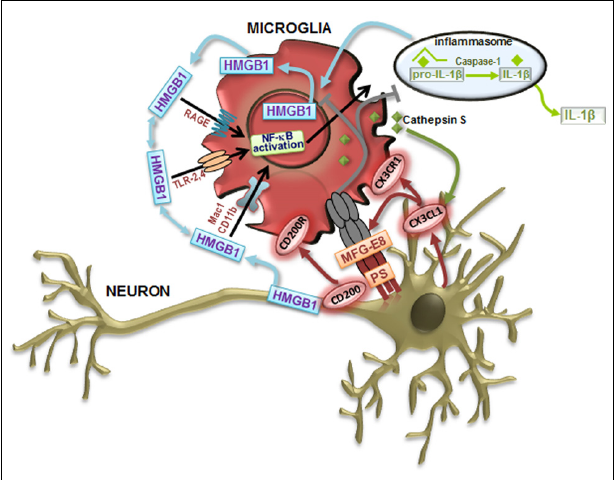
FIGURE 1 | Neuron–microglia communication signaling pathways that modulate microglia cell phenotypes. Toll-like receptor (TLR) signaling contributes to classically activated microglia (M1) in response to damage-associated molecular patterns (DAMPs). Following recognition of DAMPs,TLRs activate downstream signaling cascades, activate nuclear factor- κ B (NF- κ B) inducing the transcription of inflammatory mediators associated with the M1-like microglial cell phenotype, such as the proinflammatory cytokines interleukin (IL)-1 β and tumor necrosis factor (TNF)- α .The production of IL-1 β can be achieved by the inflammasome activation by DAMPs, leading to caspase-1 activation that orchestrates the cleavage of pro-IL-1 β to form active IL-1 β , which leaves and binds to the IL-1 receptor, resulting in inflammation. Following activation, microglial cells augment the immune response by releasing metalloproteinases (MMPs) and increasing proinflammatory cytokines. High-mobility group box 1 (HMGB1) is an alarmin that signals cell damage in response to injury and are associated to all the described signaling events. HMGB1 released by activated microglia and damaged neurons concur for a vicious cycle mediating chronic, progressive neurodegeneration associated with neuroinflammation. HMGB1 can interact with receptors that include RAGE (receptor for advanced glycation end products),TLR-2,TLR-4, Mac-1 also known as CD11b, and possibly others. Alternatively activated microglia (M2) functions include phagocytosis. Milk fat globule factor-E8 (MFG-E8) produced by microglia recognizes phosphatidylserine (PS) as “eat me” signals expressed on the surface of apoptotic neurons, triggering a signaling cascade that stimulates phagocytosis to engulf the dying cell. In order to maintain a quiescent microglia phenotype (M0) under steady-state conditions, neurons suppress the activation of microglia through cell–cell contact (CD200–CD200R) and by the release of the chemokine ligand